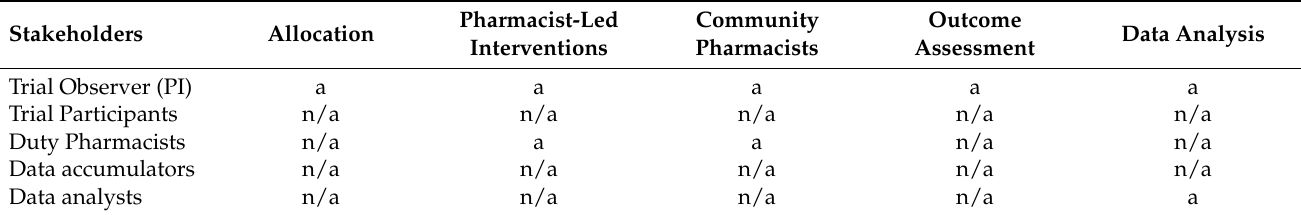
Table 3. Overall trial blinding strategies.